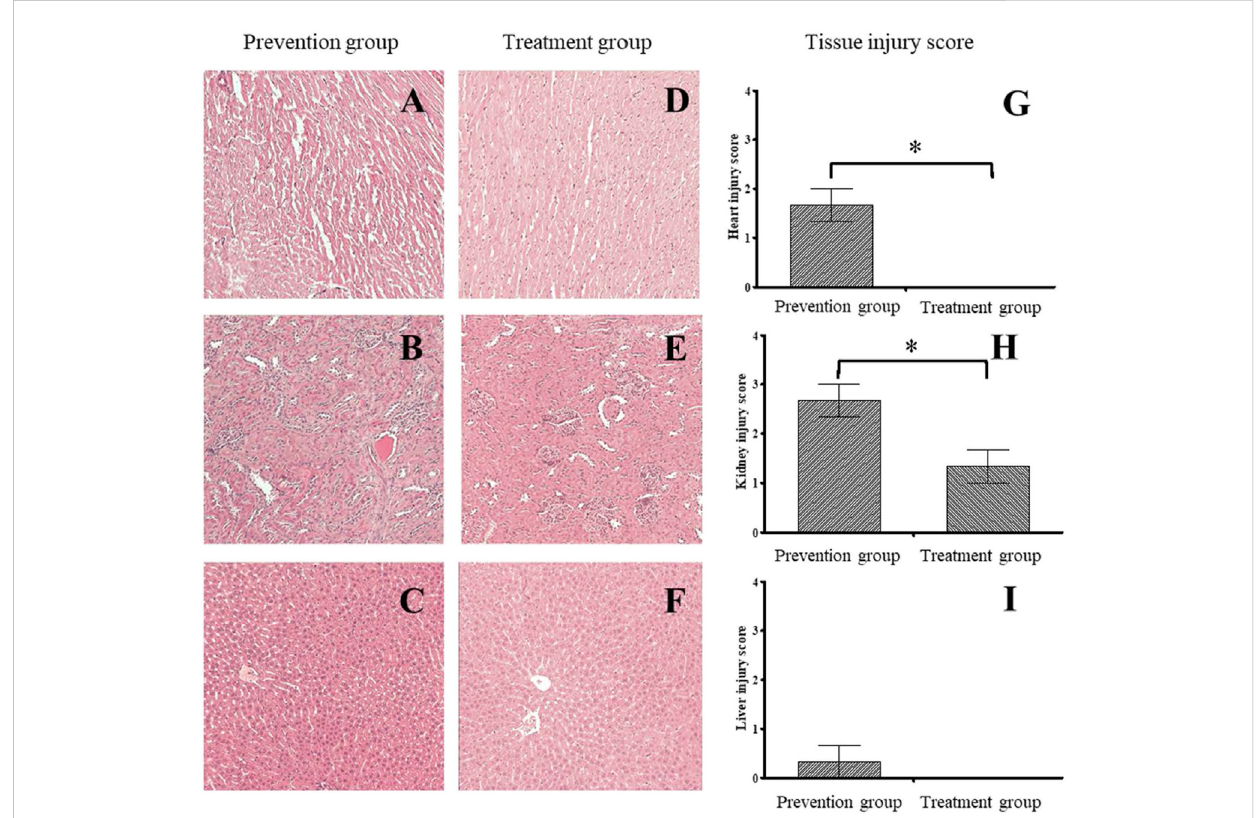
FIGURE 3 The histological fi nding and tissue injury score between prevention and treatment group. The histological examination of prevention (A – C) and treatment group (D – F) . The prevention group had higher tissue injury score on theHeart (G) and kidney (H) than those in treatmentgroup. There was no signi fi cant difference between groups on the liver (I) . *indicates p -value < 0.05, compare with prevention